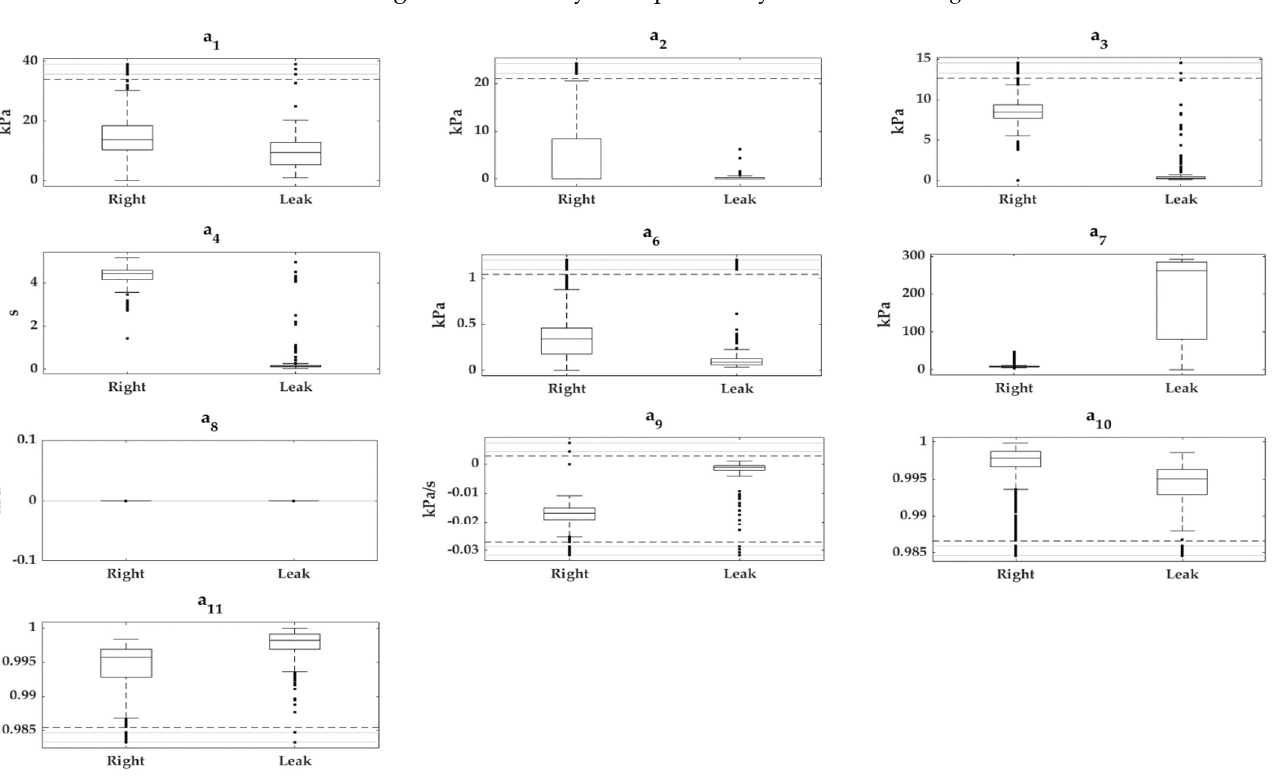
Figure 5. Box-and-whisker plots of quantitative features extracted ( a 1 – a 4 and a 6 – a 11 ) from balloon signals. The “ Right ” and “ Leak ” groups are represented for each feature; a 5 and a 12 are not presented due to their categorical nature. For additional information on the extracted features see Appendix A.